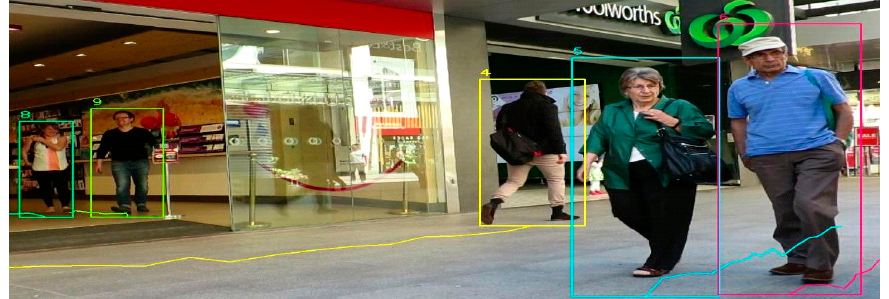
Figure 7. The proposed model (SCT) results using MOT 16-09.